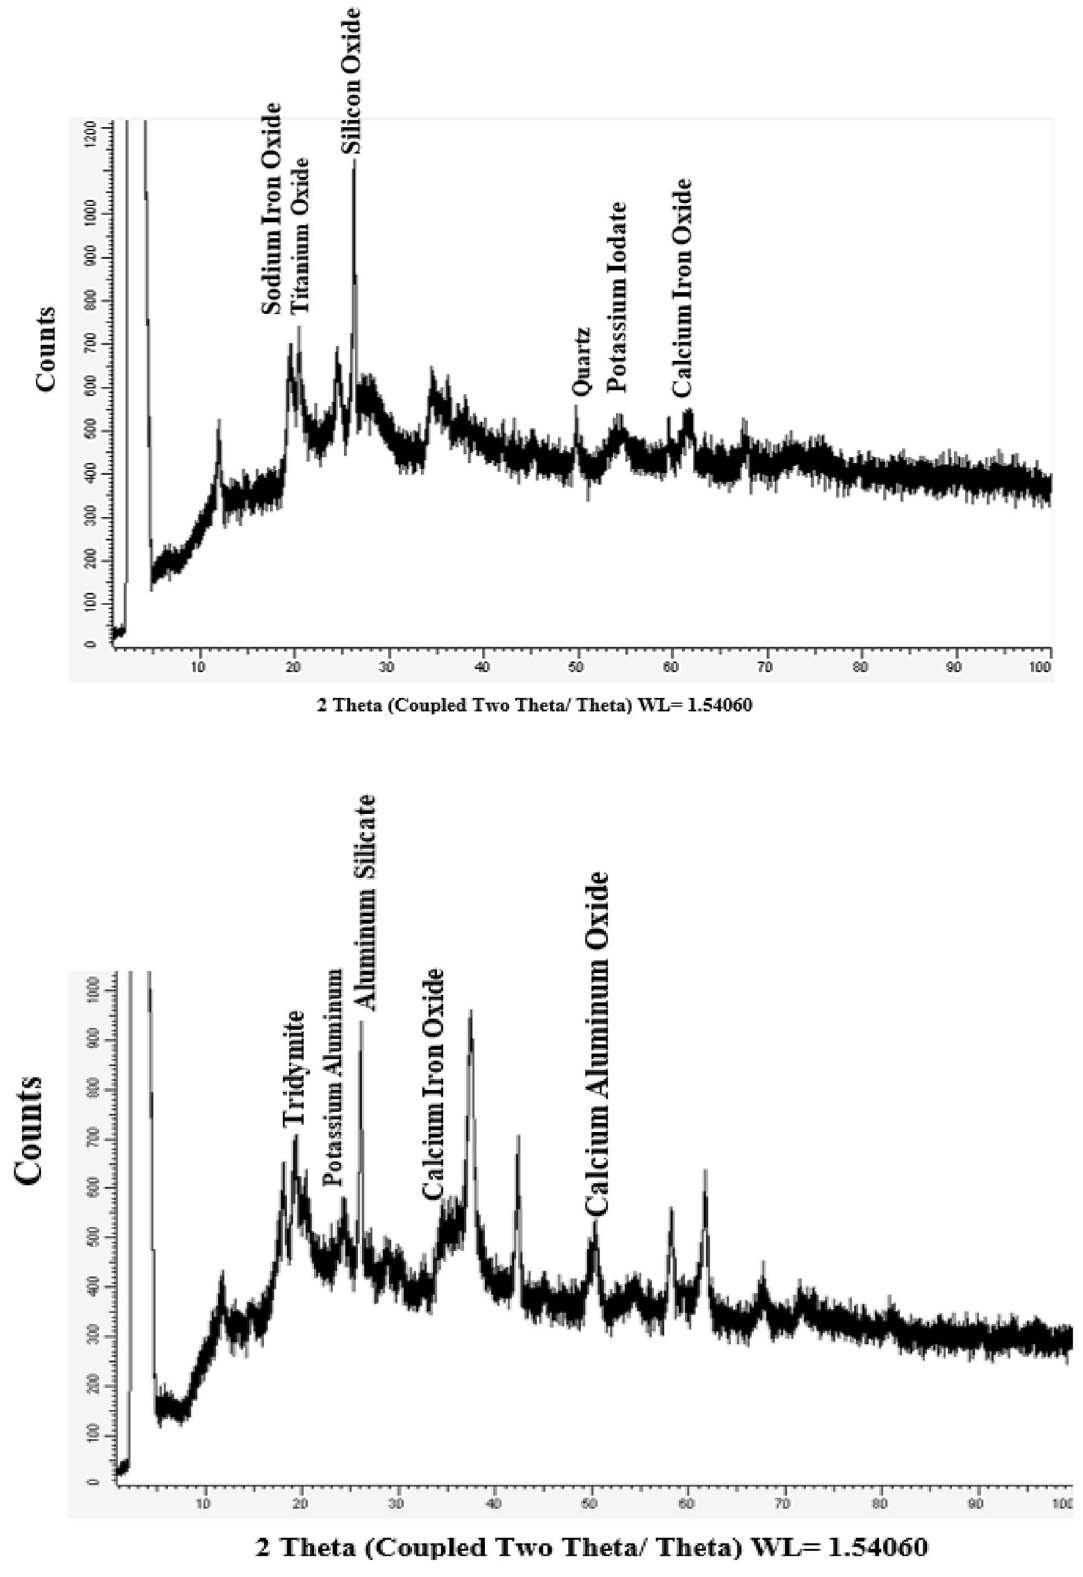
Figure 1. The X-ray diffraction (XRD) analyses of bentonite (above) and nano-composite